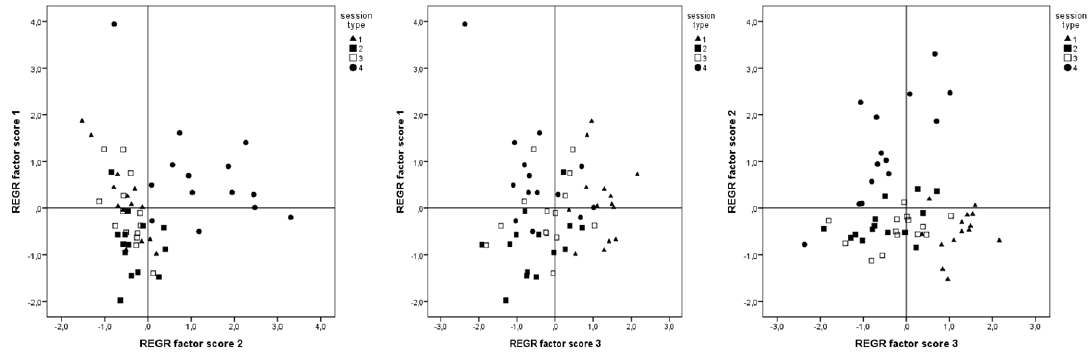
Figure 2. The variables grouped into three components. Note: The variables were grouped into three